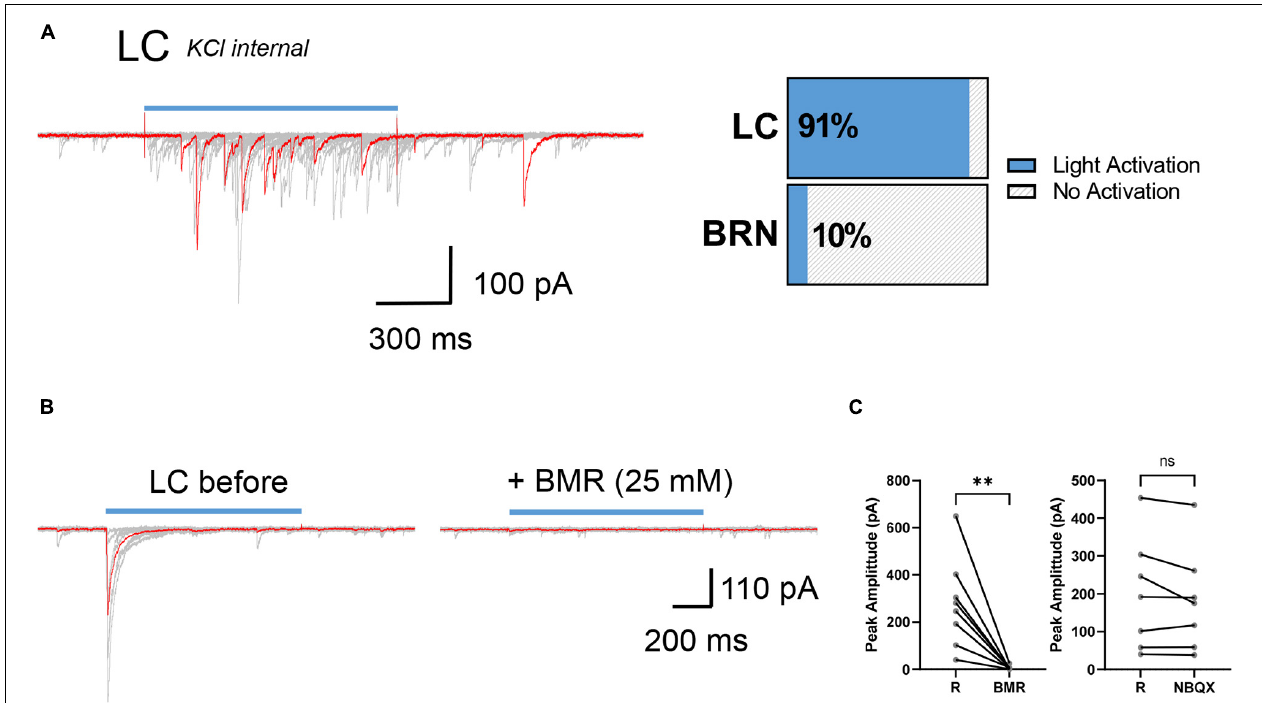
FIGURE 2 | Synaptic connectivity between SST + neurons and LC cells in Sst Cre ;chr2-yfp mice. (A) Example superimposed (red and gray) current traces recorded from a SST - neuron in the LC (KCl internal, V hold = –60 mV) after repetitive stimulation of SST + presynaptic afferents with light (left) . Horizontal slices chart represents percentage of postsynaptic SST - neurons activated by light in LC and BRN (right) . LC: n = 10 mice, 30/33 cells light activated; BRN: 3 mice, 1/10 cells light activated. (B) Example superimposed (red and gray) light activated IPSCs recorded from a LC neuron in the presence and absence of BMR (25 µ M). (C) Paired before-after plots of light-evoked IPSC in the absence (R) and the presence of BMR ( left , n = 3 mice, 8 cells; R: 277 ± 67 pA; BMR: 5.5 ± 3 pA) and the absence (R) and presence of NBQX ( right , n = 3 mice, 7 cells; R:199 ± 56 pA; NBQX: 182 ± 51 pA) mean ± SEM. ** p ≤ 0.01; ns, not significant. Wilcoxon matched-pairs signed rank